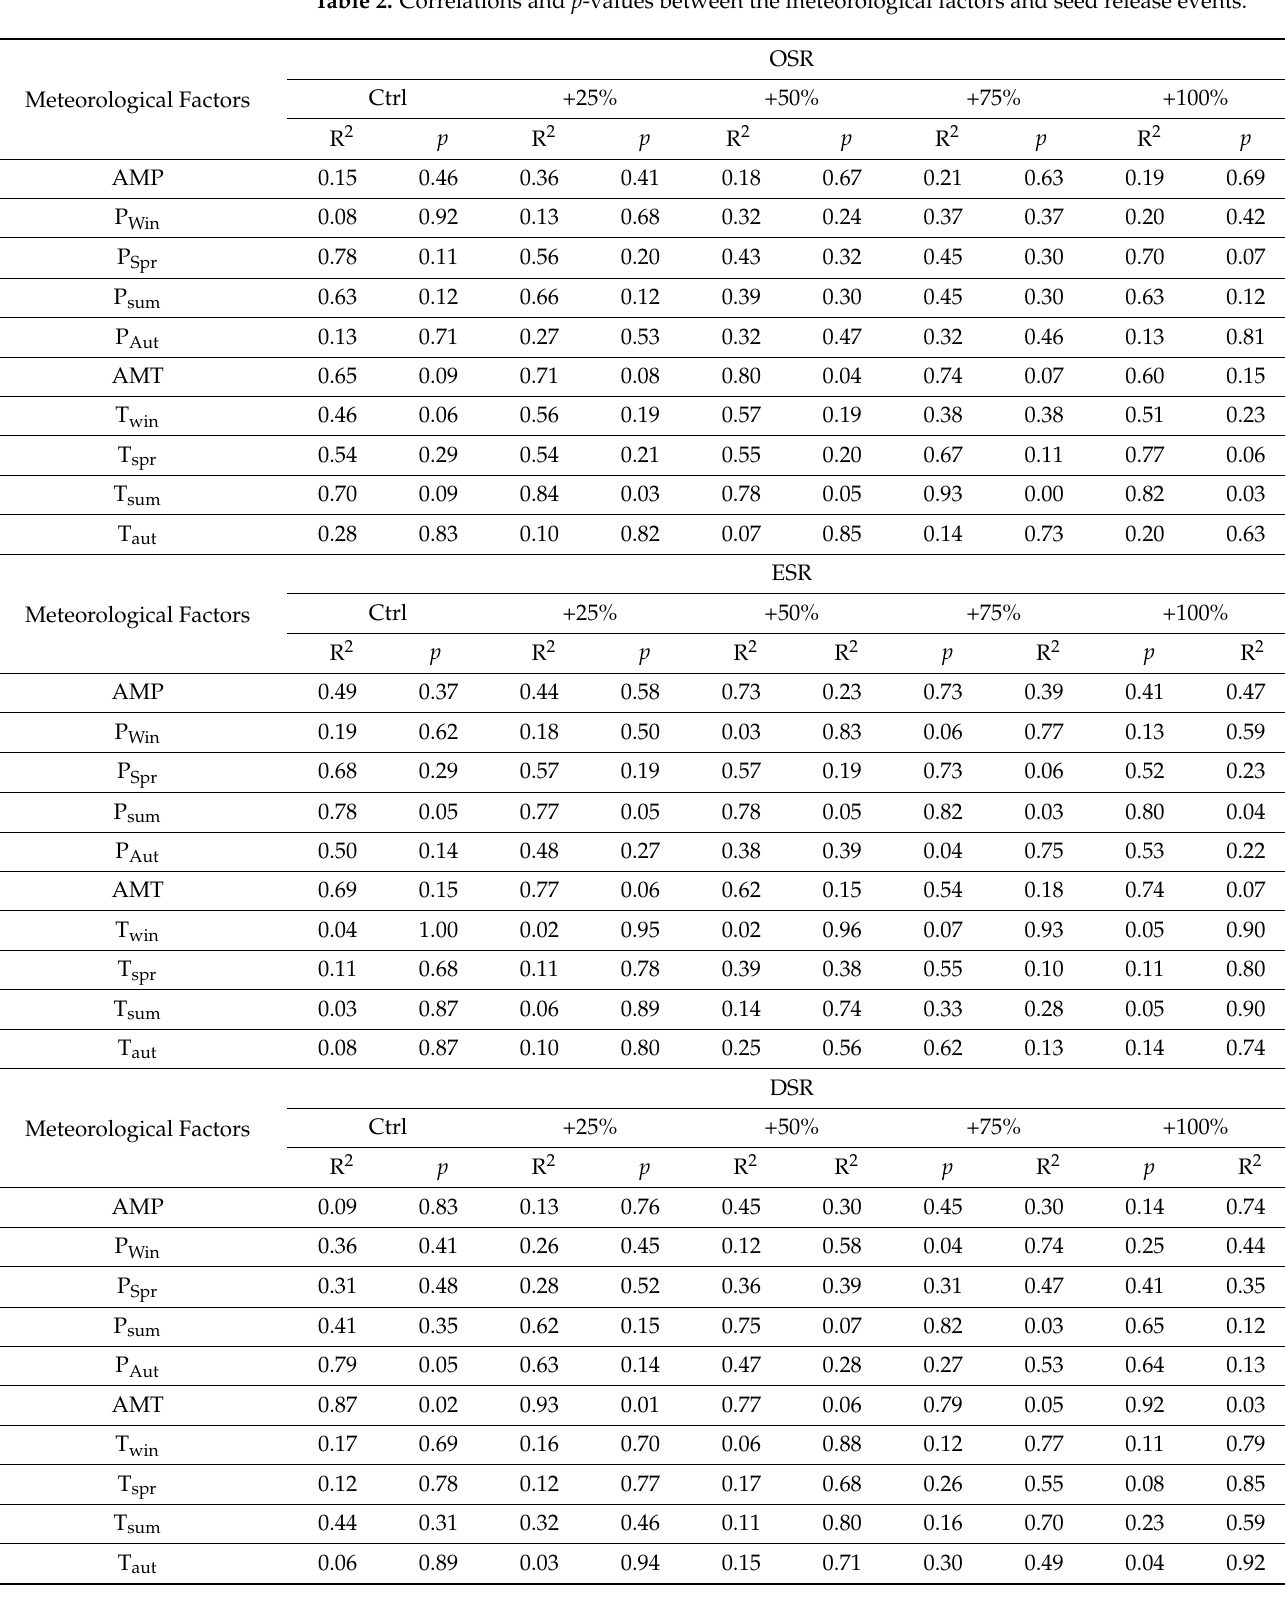
Table 2. Correlations and p -values between the meteorological factors and seed release